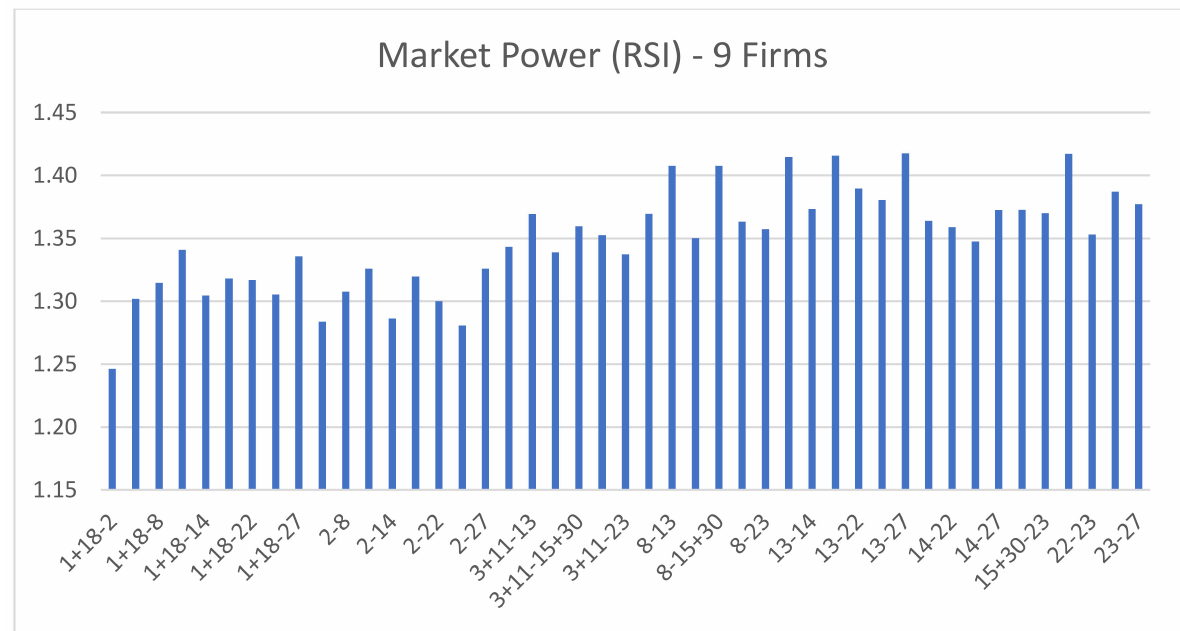
Figure 8. RSI for 9 firms’ setting